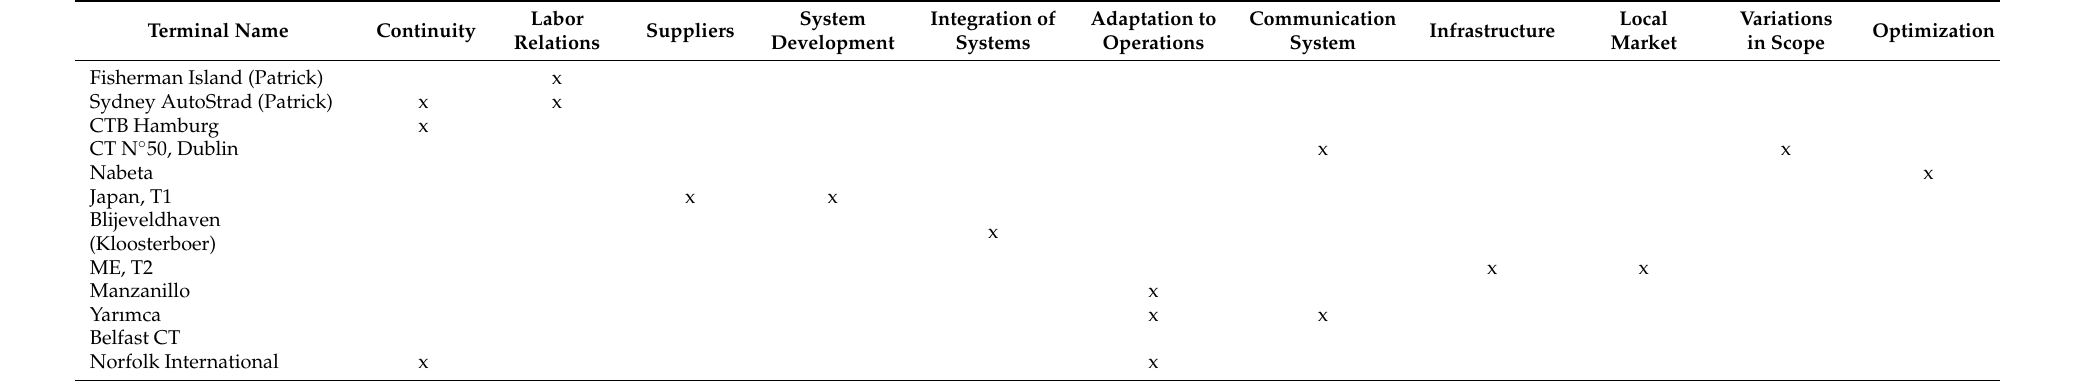
Table A2. Challenges for converting to automated operations identified from questionnaire